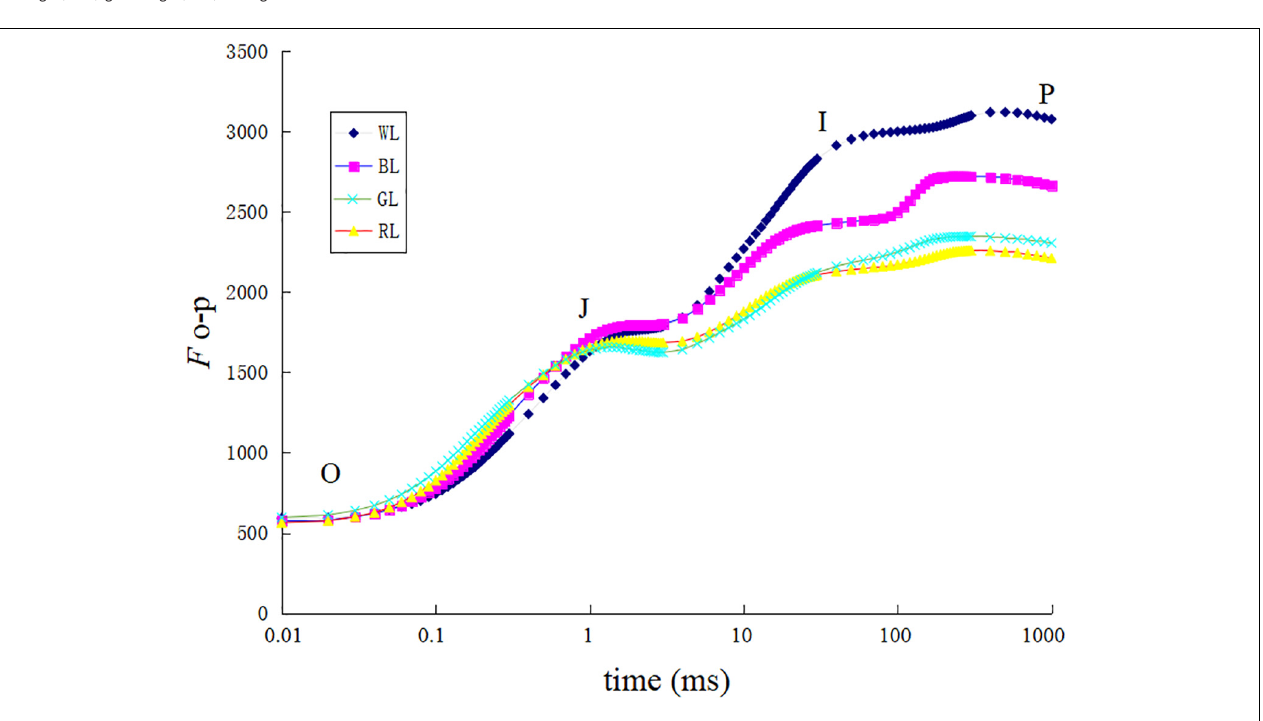
FIGURE 5 | Chlorophyll a fluorescence transient of dark adapted leaves exposed to different LED light